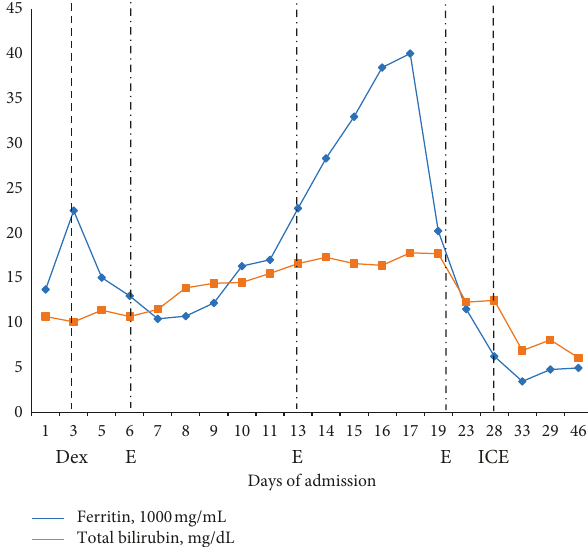
Figure 2: Ferritin and total bilirubin throughout hospital course. Dex � dexamethasone administration; E � etoposide administra- tion; ICE � ifosfamide, carboplatin, and etoposide